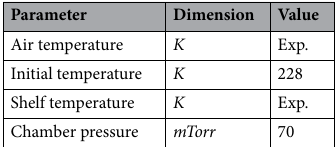
Table 3. Process simulation parameters.